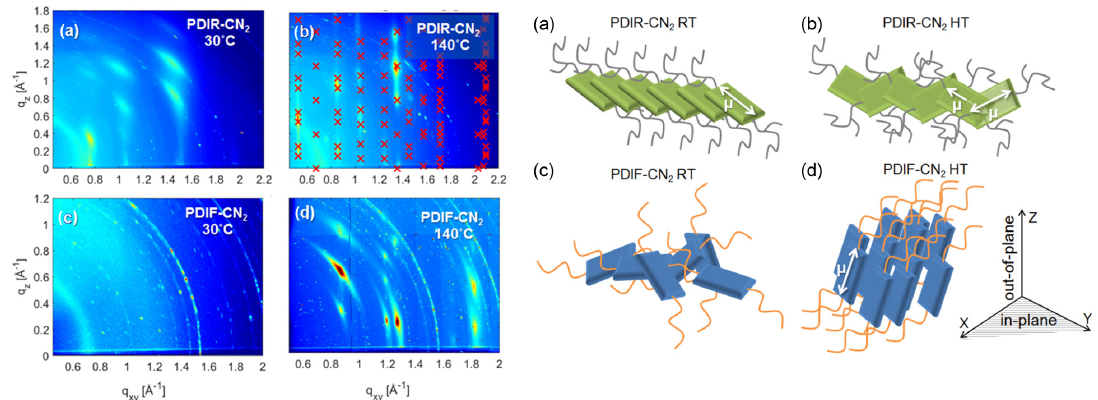
Figure 23. Schematic representations of molecular arrangements in ( a ) PDIR-CN2 RT-phase, ( b ) PDIR-CN2 HT-phase, ( c ) amorphous PDIF-CN2, and ( d ) PDIF-CN2 thin film crystal phases together (cid:113) with corresponding GID measurements, where q xy = q 2 x + q 2 y . Adapted from Belova et al. [219]